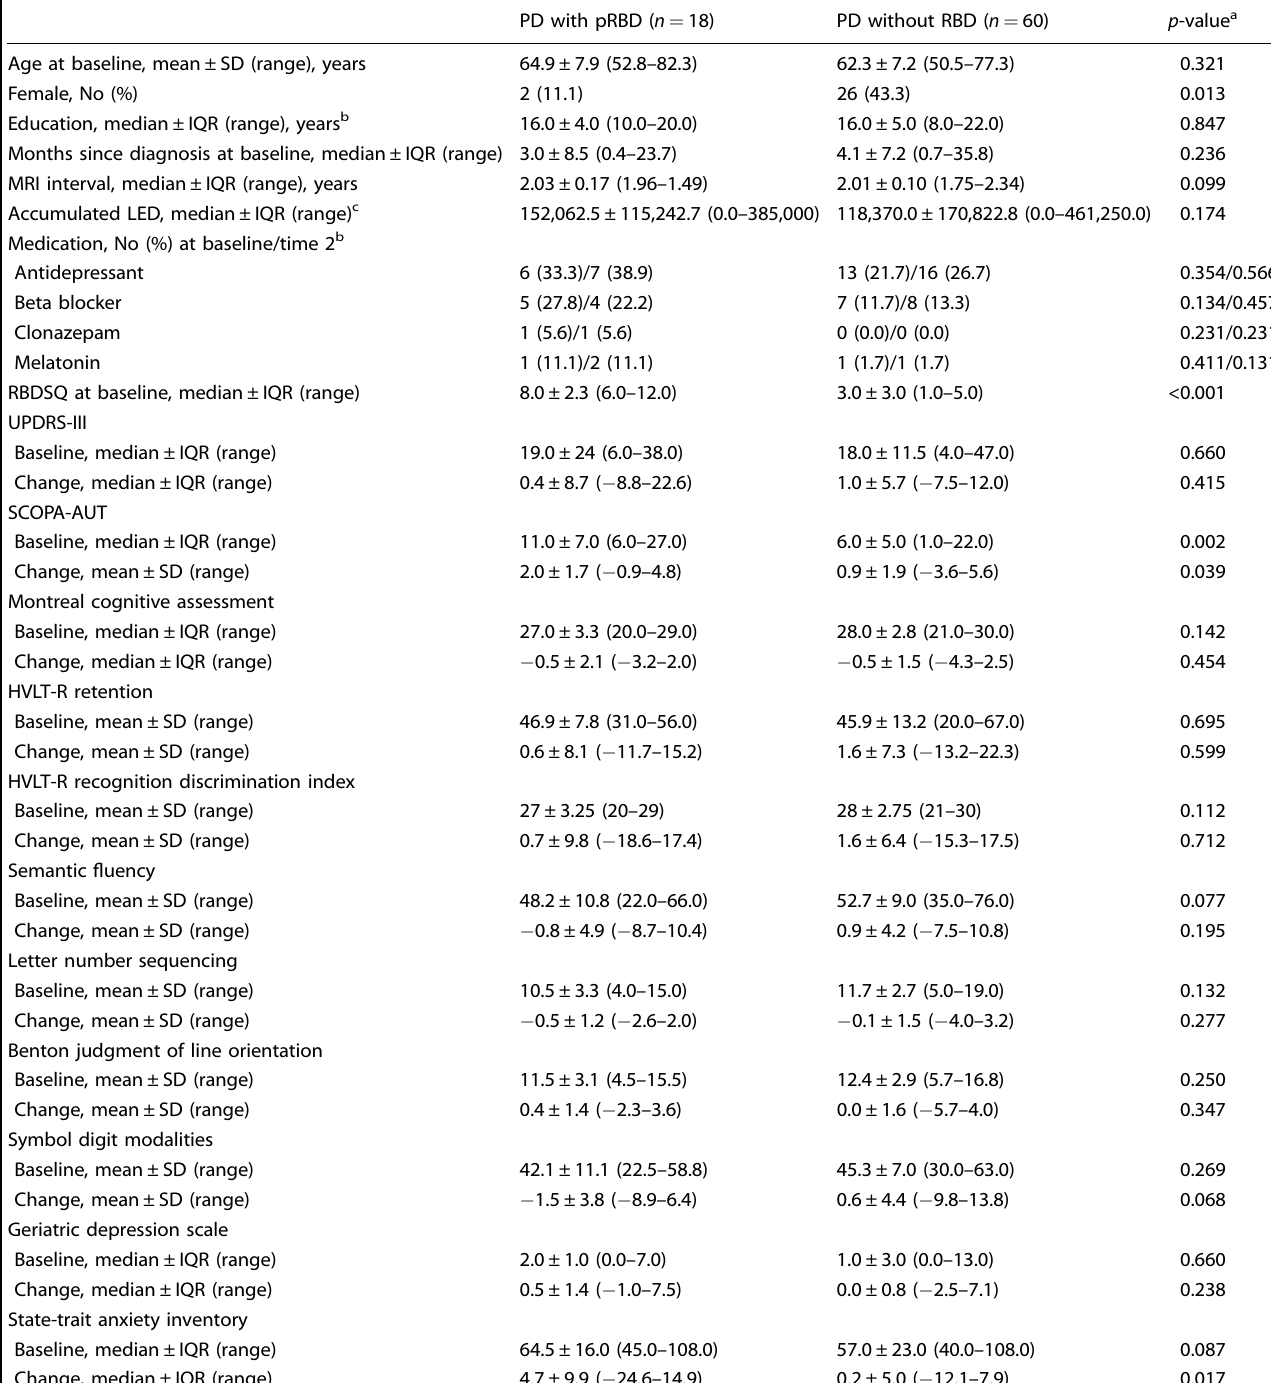
Table 1. Demographic and clinical data. PD with pRBD ( n = 18) PD without RBD ( n = 60) p -value